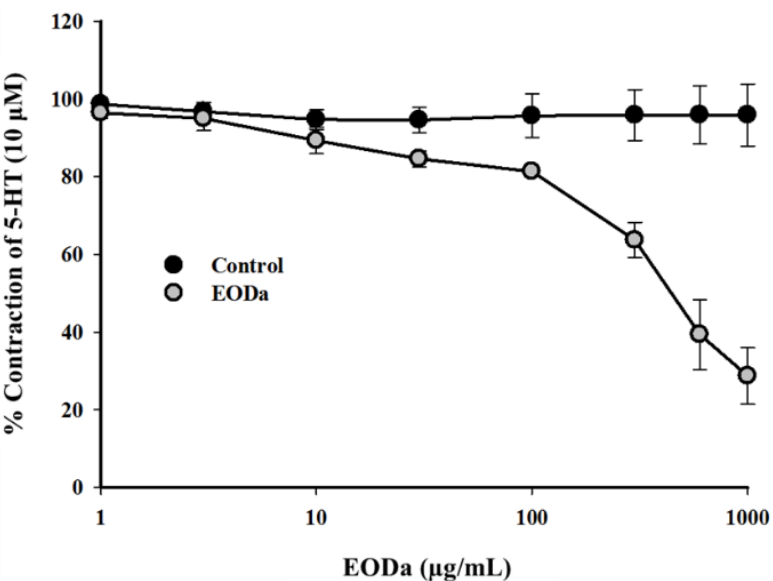
Figure 3. Relaxant effect of the EODa on contractions maintained by serotonin in isolated swine coronary arteries. Representative graph of the relaxant effect of the EODa on contractions maintained by 5-TH in isolated swine coronary arteries. Values are expressed as the mean ± S.E.M.; n represents the number of experiments ( p < 0.005, one-way ANOVA followed by Holm-Sidak).